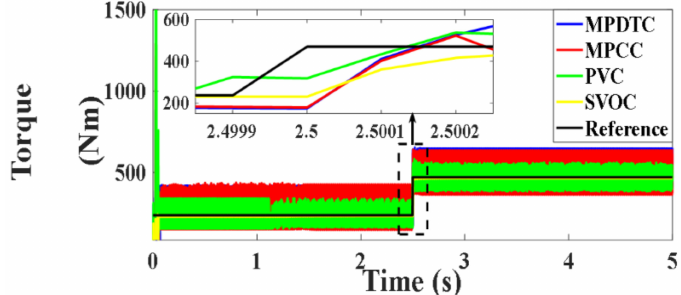
Figure 193. Comparison between torques of four techniques (Nm).